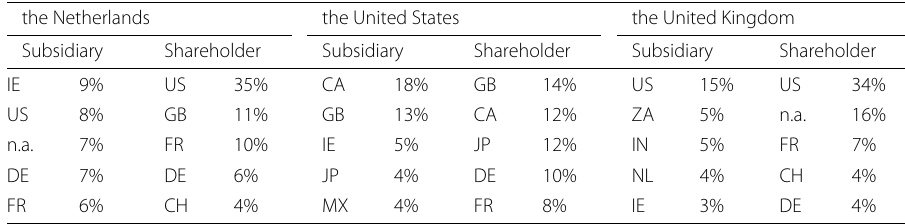
Table 3 Direct shareholders and subsidiaries of the “holding”